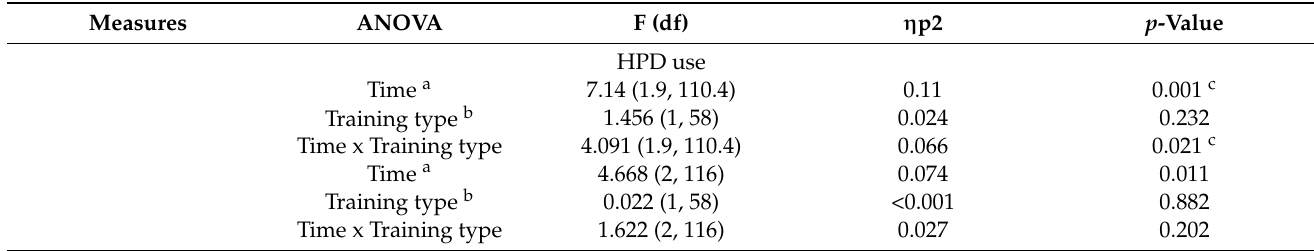
Table 4. Changes in HPD use and intention to use HPD according to training types—Repeated Measures